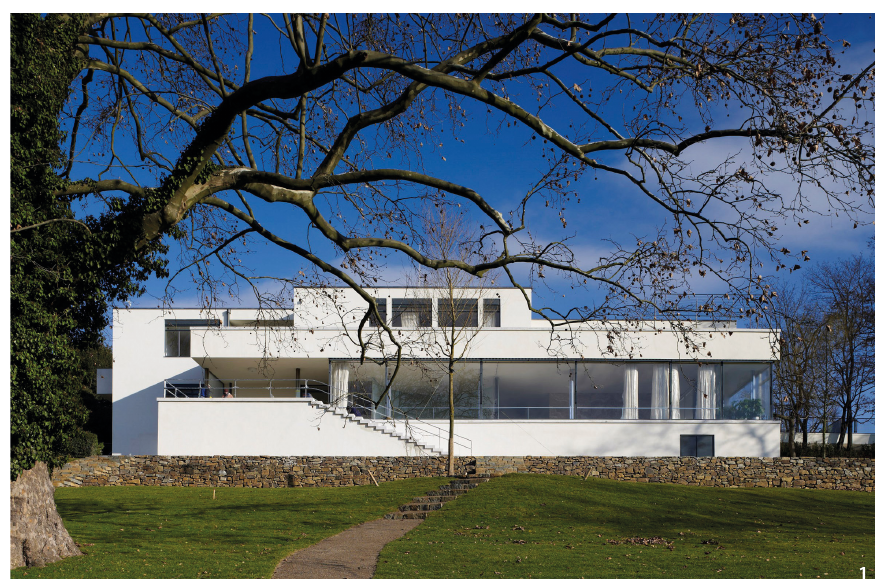
Figure 1 Mies van der Rohe and Lilly Reich, Tugendhat House, Brno, Czech Republic, 1929–1930. Garden façade, after restoration (Source: Alex